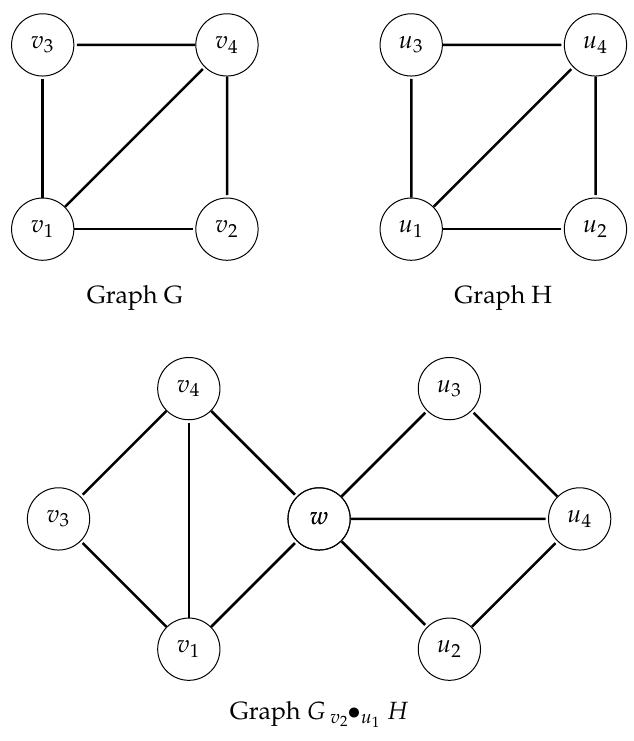
Figure 1. The append of two